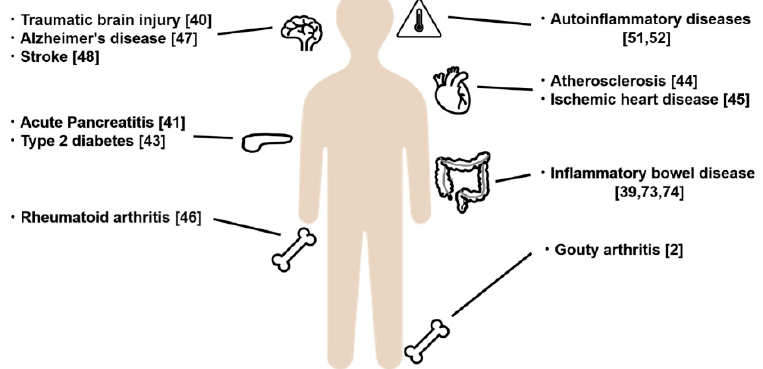
Figure 5. Diseases associated with inflammasome dysfunction. NOD-like receptor family pyrin domain-containing 3 (NLRP3) inflammasome dysfunction can trigger or exacerbate various types of inflammatory and immune-related diseases in different organs. NLRP3, NOD-like receptor family pyrin domain-containing 3.